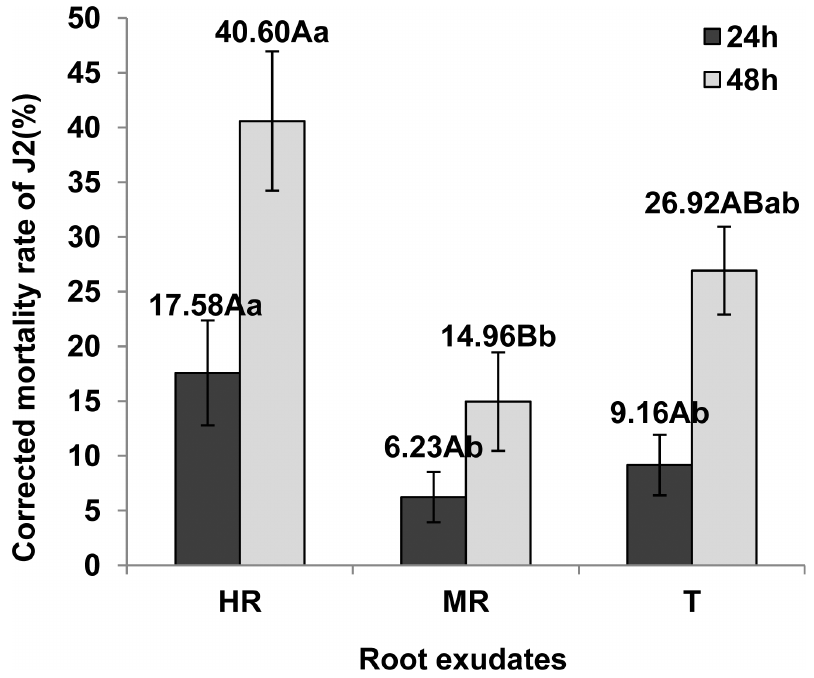
Fig 3. Effects of root exudates on corrected mortality of M . incognita J2. HR, MR and T represent the root exudates from three tomato strains: Baliya (highly resistant), RS2 (moderately resistant) and L-402 (highly susceptible), respectively. The mortality of J2 in each root exudate (sterilized water as control) was assessed by the eyelash needle stimulus method at 24 h and 48 h after starting the assay. Corrected mortality rate (%) = (mortality rate of J2 in root exudate — mortality rate of J2 in sterilized water) / (1 — mortality rate of J2 in sterilized water) ×100. Each bar represents the mean, and error bars indicate standard error of the mean from three replicates. Capital and lower case letters indicate significant group differences at the levels of 0.01 and 0.05, respectively.